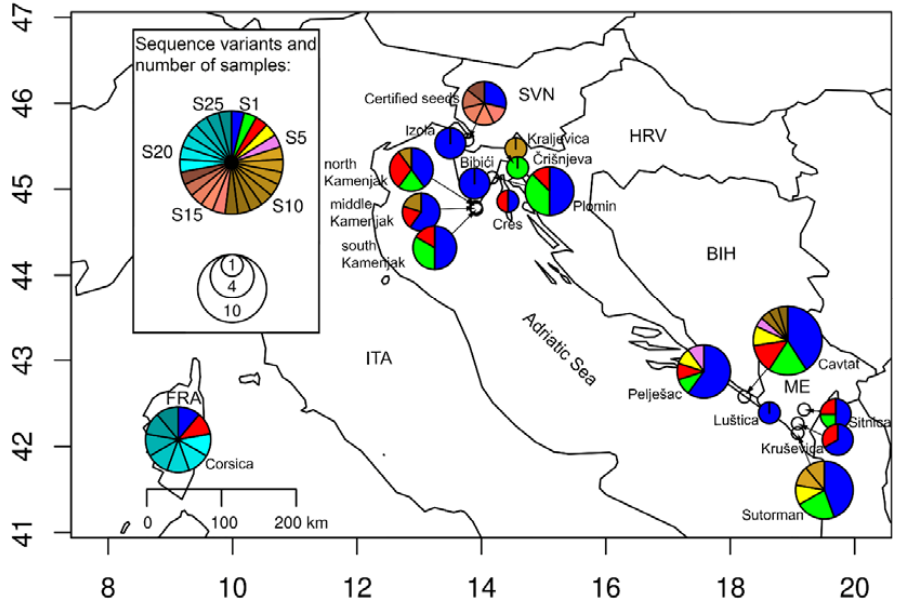
Figure 1. Distribution of identified ITS1-5.8S-ITS2 sequence variants across the North-East and South-East Adriatic regions. Sequences from Corsica were obtained from the NCBI Nucleotide da- tabase. The radii of pie charts indicate the number of samples per location (from 1 to 10), whereas the sizes of the slices present the relative abundances of sequence variants. The most frequently observed sequence variants, labeled 1 to 5, were marked with distinct colors, whereas sequences identified at single samples were marked with similar color shades, based on their origins (S6 to S13 North-East and South-East Adriatic region, S14 to S18 certified seeds (identified as HL) and S19 to S25 GenBank sequences from Corsica plants).